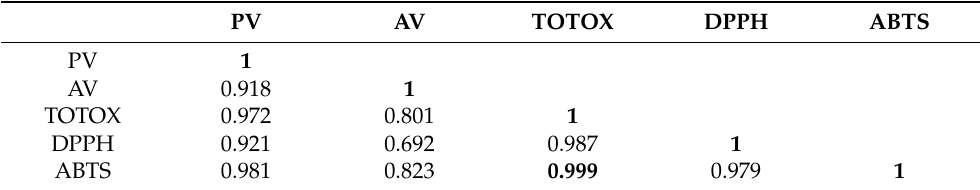
Values in bold are different from 0 with a significance level alpha = 0.05. SO—sunflower oil, AV— ρ -Anisidine value, PV—peroxide value TOTOX—total oxidation value, DPPH—2.2-diphenyl-1-picryl hydrazyl, ABTS—2.2 (cid:48)